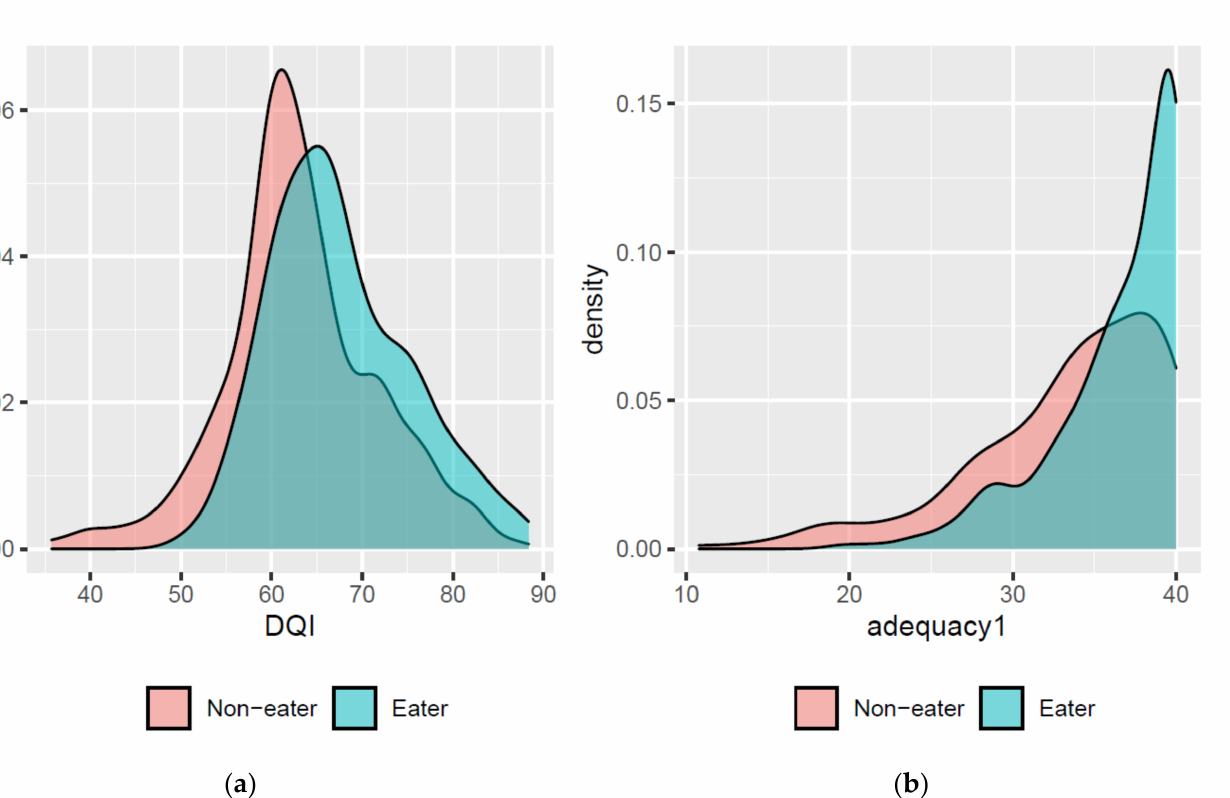
Figure 1. ( a ) Distribution densities of the DQI scores indicate a “shift” to an improved diet quality for avocado consumers compared to non-consumers among adolescents. ( b ) Although both groups seem to have adequate intake, the adequacy of intake is greater among avocado